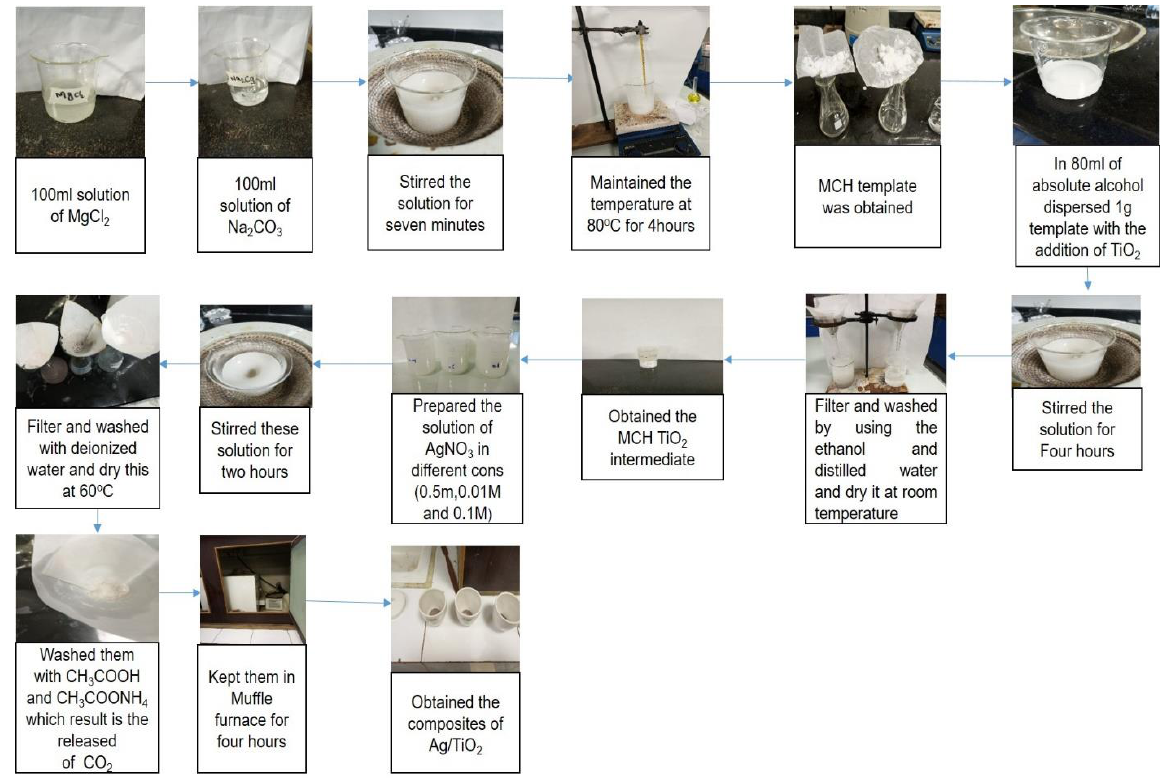
Figure 1. Schematic diagram of the synthesis of Ag/TiO 2 composites by template induced route.